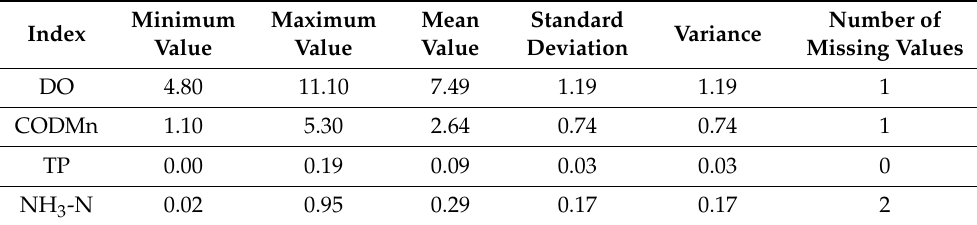
Table 2. Descriptive statistics of experimental dataset.